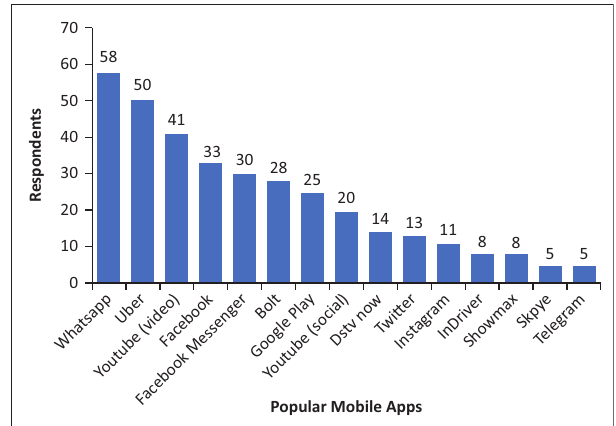
FIGURE 1: Top 10 Android apps in South Africa, September 2019.